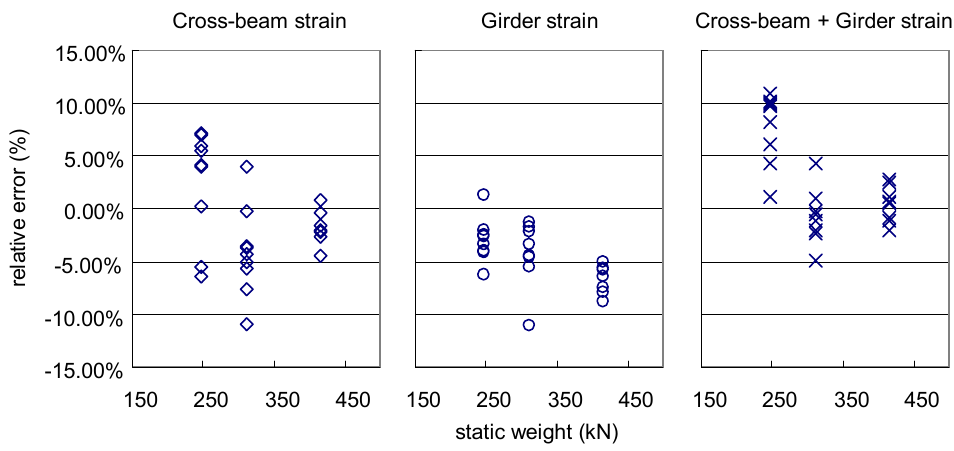
Figure 10. Performance comparison between ANN input parameters (Geumdang